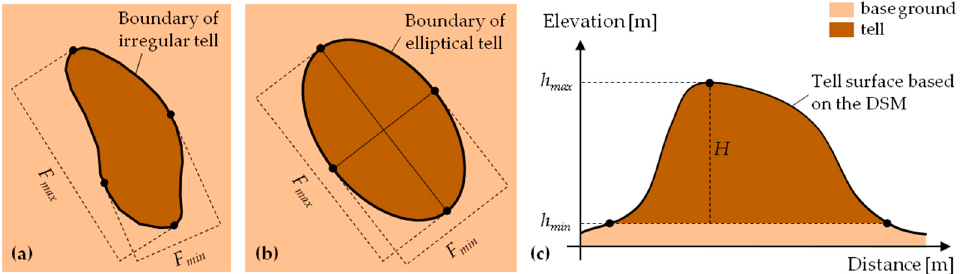
Figure 2. Sketch of archaeological tells and identification of their main dimensional parameters: planar view of ( a ) irregular and ( b ) elliptical tells, and ( c ) cross-section. Notation: F max and F min , maximum and minimum Feret diameters; H , height; h max and h min , top and base elevation, respectively.